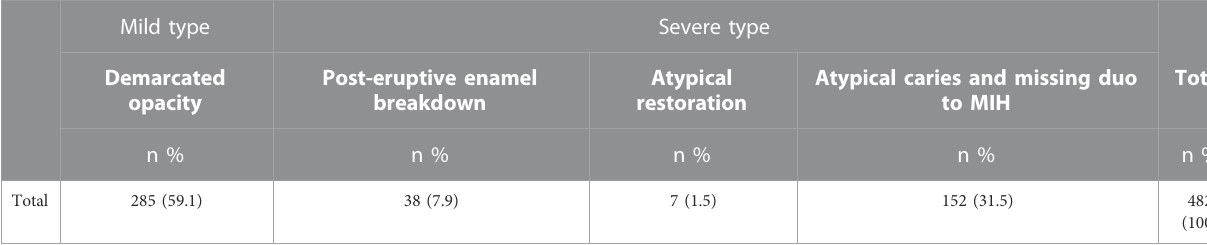
TABLE 2 Severity of MIH (number of teeth).